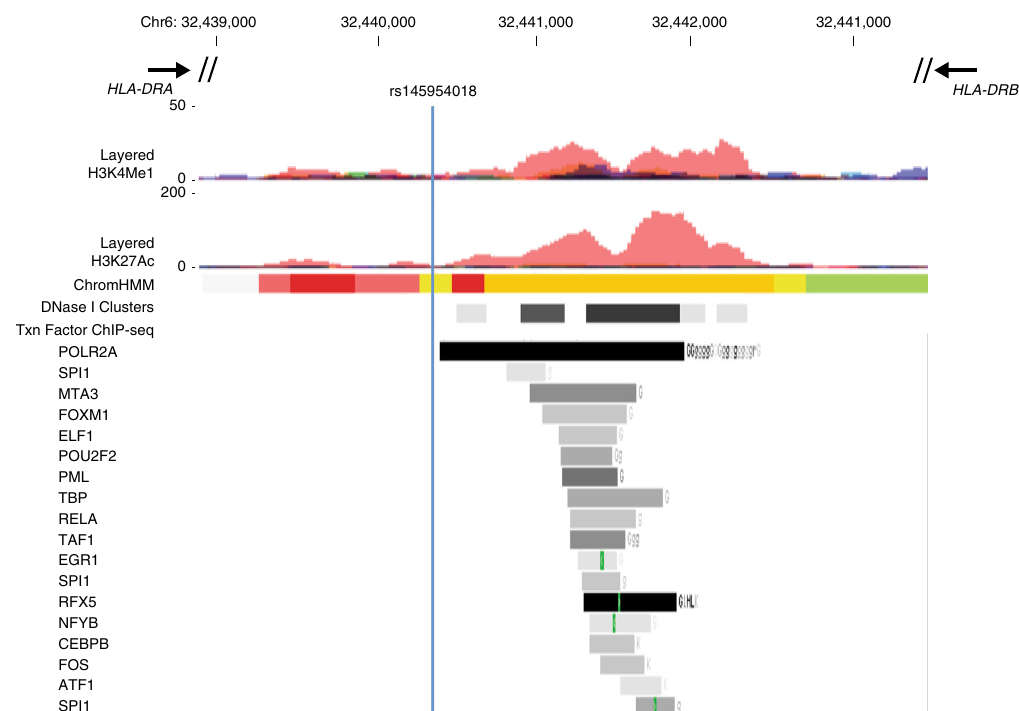
Fig. 4 rs145954018 is located within transcriptional enhancer ENSR00000195683. The blue vertical line indicates the position of the rs145954018 indel variant. Layered H3K27Ac and H3K4Me1 marks, hidden Markov model chromatin state segmentation (ChromHMM), DNase I hypersensitive site cluster (DNase I Clusters), and transcription factor chromatin immunoprecipitation sequencing (abbreviated Txn Factor ChIP-seq) data are from ENCODE 11,36 . For layered H3K27Ac and H3K4Me1 marks, data are shown for the seven cell lines studied by ENCODE. For ChromHMM, red indicates active promoter, orange indicates strong enhancer, and yellow indicates weak/poised enhancer; data shown are for GM12878 B lymphoblastoid cells. For DNase clusters, darkness indicates relative signal strength in 125 cell types from ENCODE (V3). For Txn factor ChIP-seq, darkness indicates relative signal strength of aggregate binding of 161 transcription factors, and green bars indicate ENCODE Factorbook 37 canonical motifs for speci fi c transcription